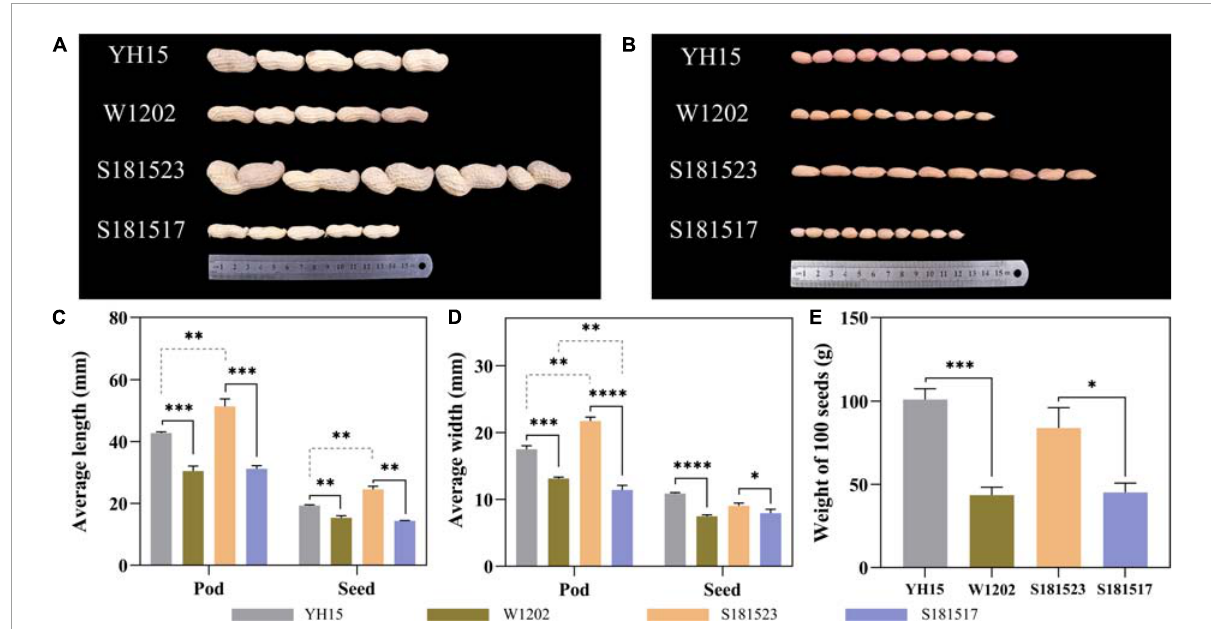
FIGURE1 Phenotypes and statistics of YH15, W1202, S181523, and S181527. (A) Pods of YH15, W1202, S181523, and S181527. (B) Seeds of YH15, W1202, S181523, and S181527. (C–E) Statistics of pod and seed length, width, and 100-seed weight. Error bars represent SD. *, **, ***, and **** represent p ≤ 0.05, ** p ≤ 0.01, *** p ≤ 0.001, and **** p ≤ 0.0001,